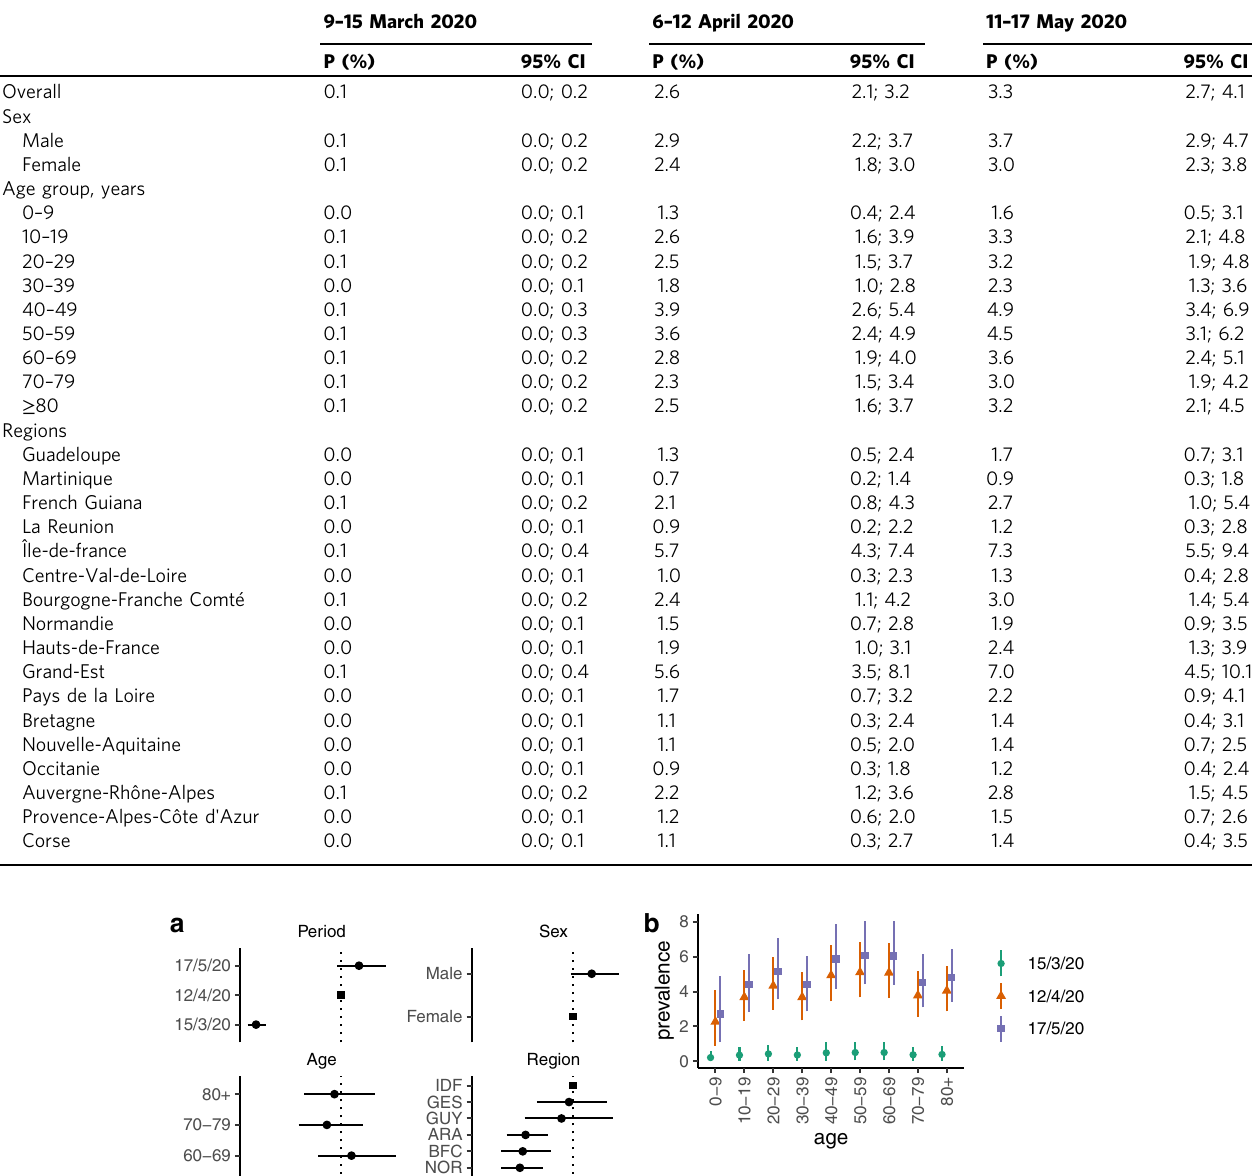
Table 1 Estimated prevalence of SARS-CoV-2 neutralising antibodies in the French population from March-May 2020.